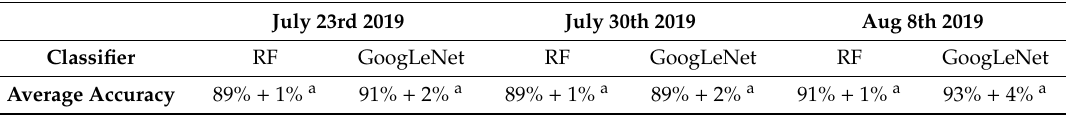
Table 2. Accuracy comparisons of Random Forest (RF) and GoogLeNet on wheat lodging plot detection for three individual date datasets. Di ff erent letters in the same date are significantly di ff erent by Tukey’s test at 0.05 significance